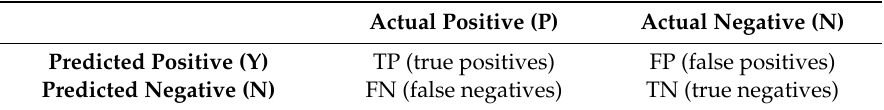
Table 3. Confusion